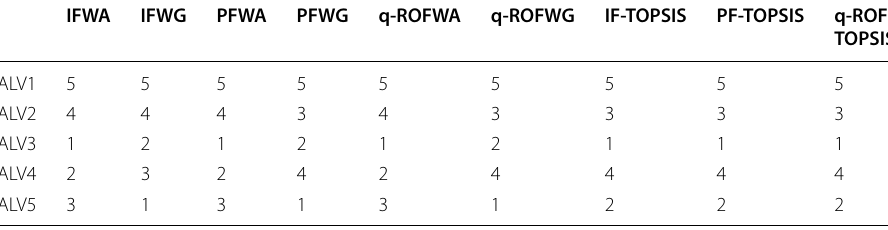
Table 13 Comparative ranking results for the alternatives